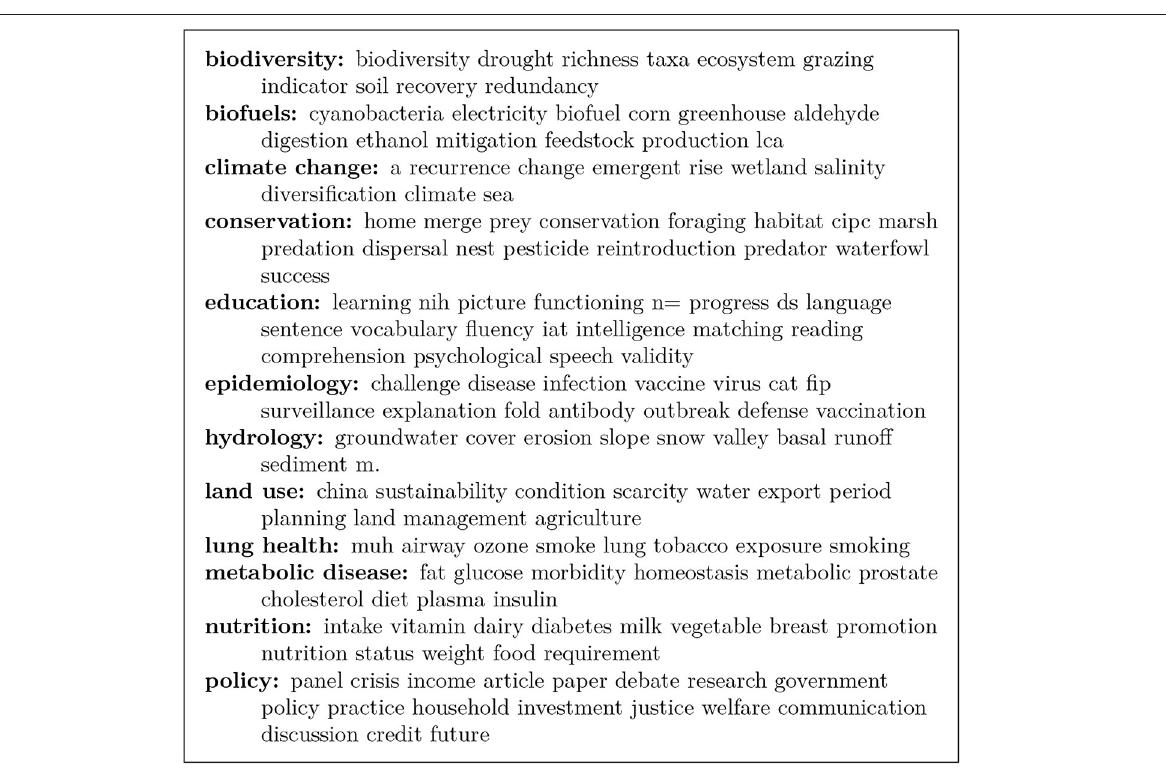
FIGURE 3 | Term lists for selected affinity propagation clusters. Labels were assigned